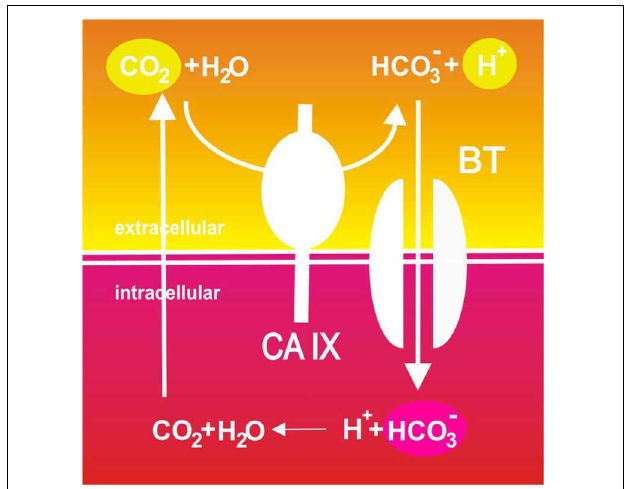
FIGURE 2 | Schematic illustration of the catalytic role of CA IX in pH regulation in tumor cells. Pericellular CO 2 is hydrated to bicarbonate ions and protons in a reaction efficiently catalyzed by the hypoxia-induced CA IX. Protons remain on the outer side of the plasma membrane and contribute to extracellular acidification. On the other hand, CA IX-facilitated production of bicarbonate ions is spatially and functionally coupled to their inward transport across the plasma membrane through bicarbonate transporters (BT) where these ions consume cytoplasmic protons and neutralize intracellular pH. This results in production of CO 2 that leaves the cell by diffusion and may enter a new round of